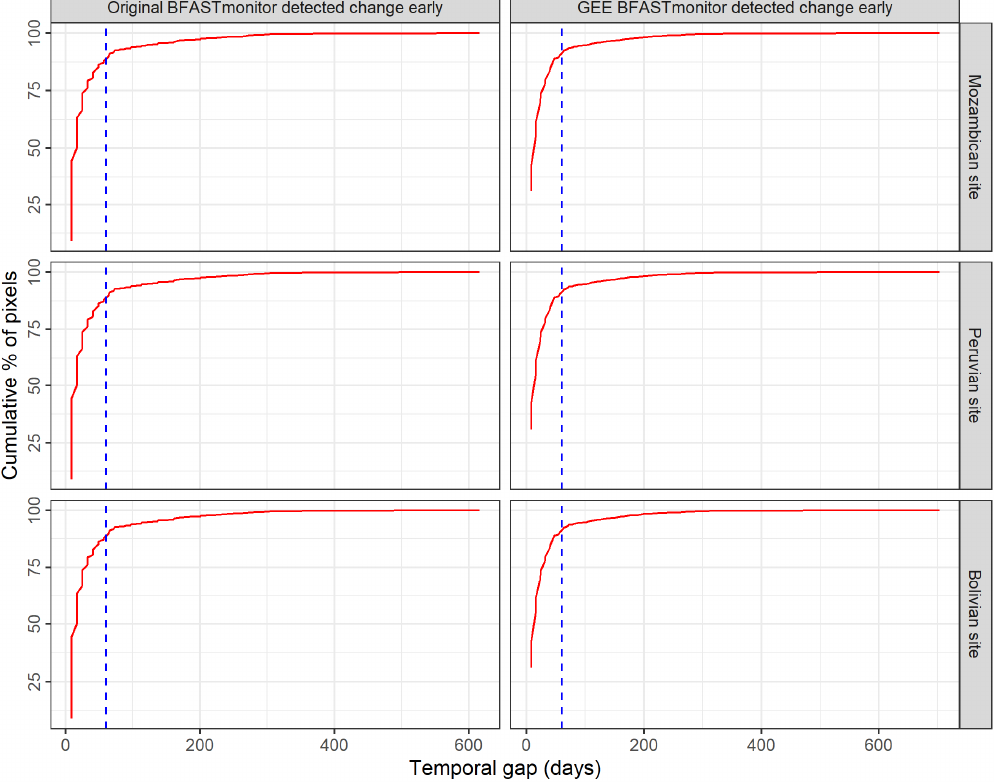
Figure A1. More than 85% of pixels with temporal disagreement between original and GEE BFASTmonitor at each site had disturbances detected with a temporal gap of not more than 60 days. Cumulative % of the pixels plotted against the temporal gap for pixels with temporal disagreement between original and GEE BFASTmonitor. The vertical dashed line (in blue) represents the temporal gap of 60